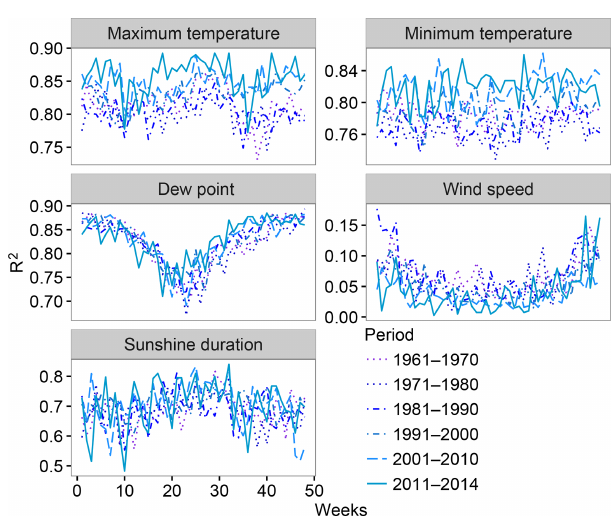
Figure 8. Spatial validation of the interpolation in terms of R 2 , grouped by decadal